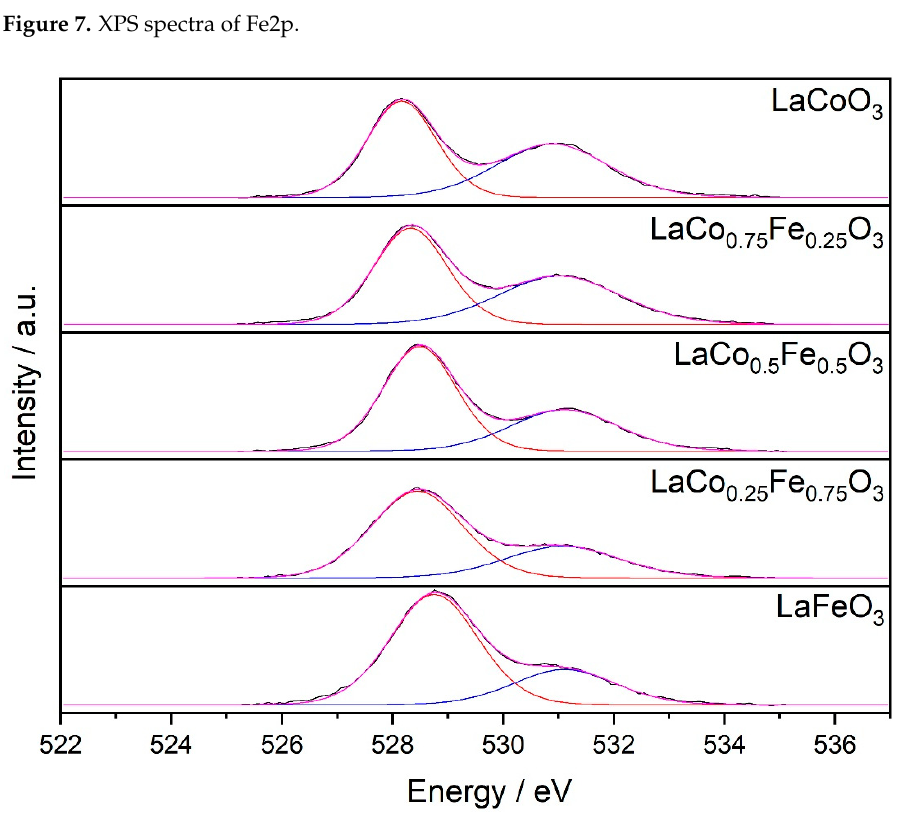
Figure 8. XPS spectra of O1s. Table 6. Co 3+ /Co 2+ magnetic moments.